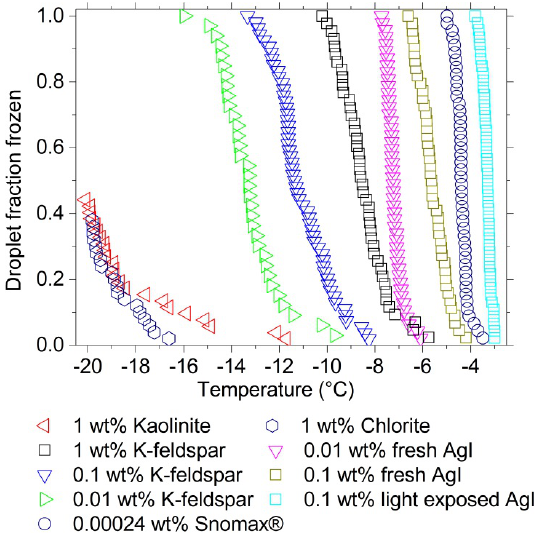
Figure 6. Temperature against fraction frozen for a variety of nu- cleants with a range of concentrations. The freezing temperature of droplets containing K-feldspar can be seen to steadily increase with increasing K-feldspar contamination.